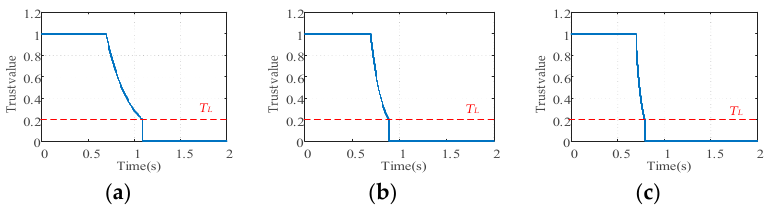
different isolation threshold 𝑇 (cid:3013) and rejoining threshold 𝑇 (cid:3009) .